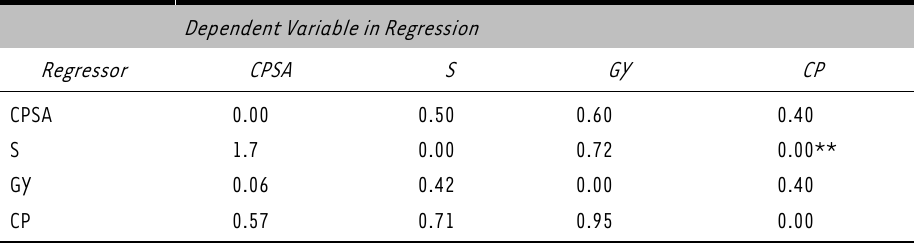
Granger causality tests for exchange rate pass-through Dependent Variable in